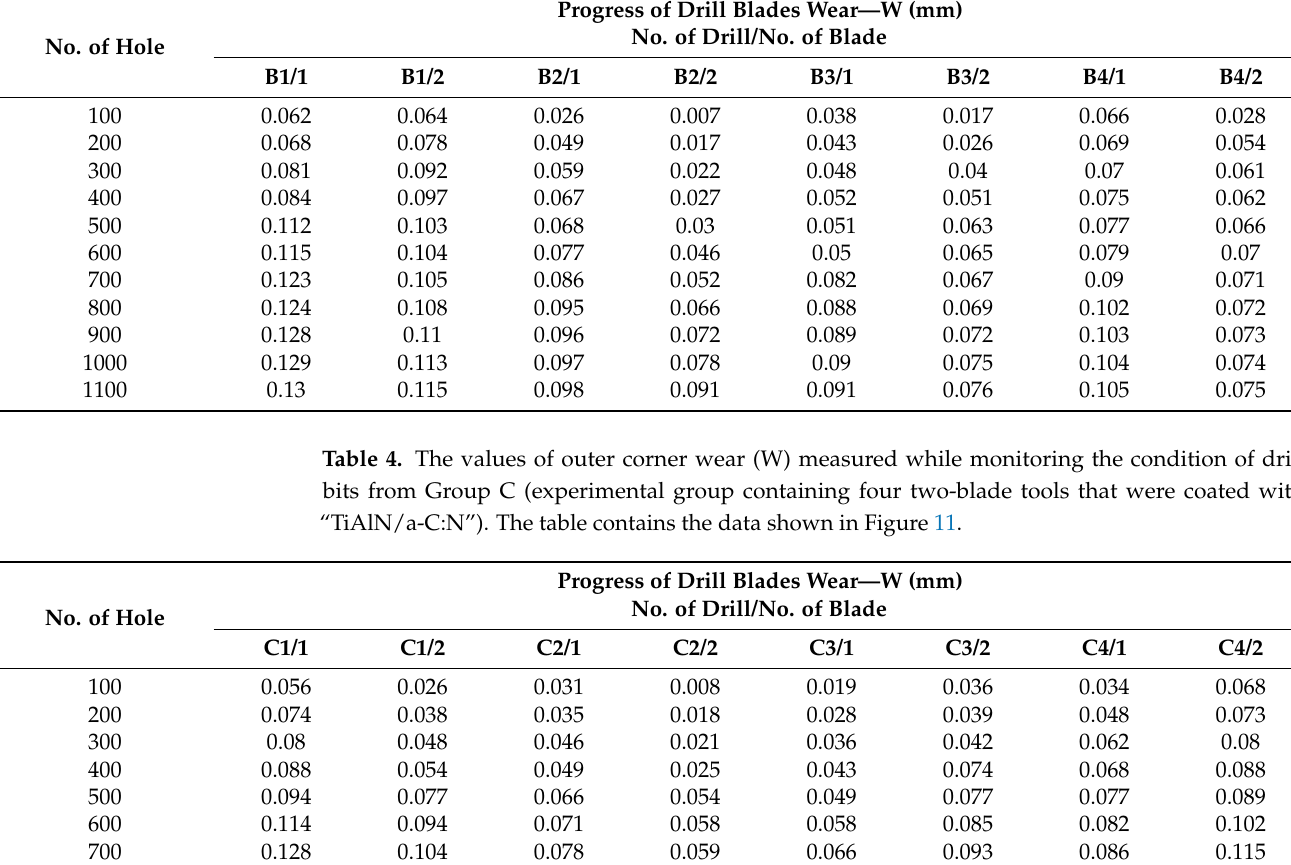
Table 3. The values of outer corner wear (W) measured while monitoring the condition of drill bits from Group B (experimental group containing four two-blade tools that were coated with “TiN/AlTiN”). The table contains the data shown in Figure 10.